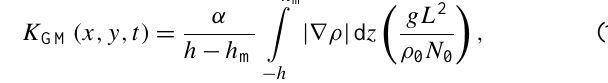
Table 1. List of Reanalysis surface winds (speed and stress fields) used in this study. 20CR is an ensemble Reanalysis, and here we have used the ensemble mean. NCEP/DOE = National Centers for Environmental Prediction /Department of Energy; CFSR = Climate Forecast System Reanalysis; MERRA = Modern Era Retrospective Analysis for Research and